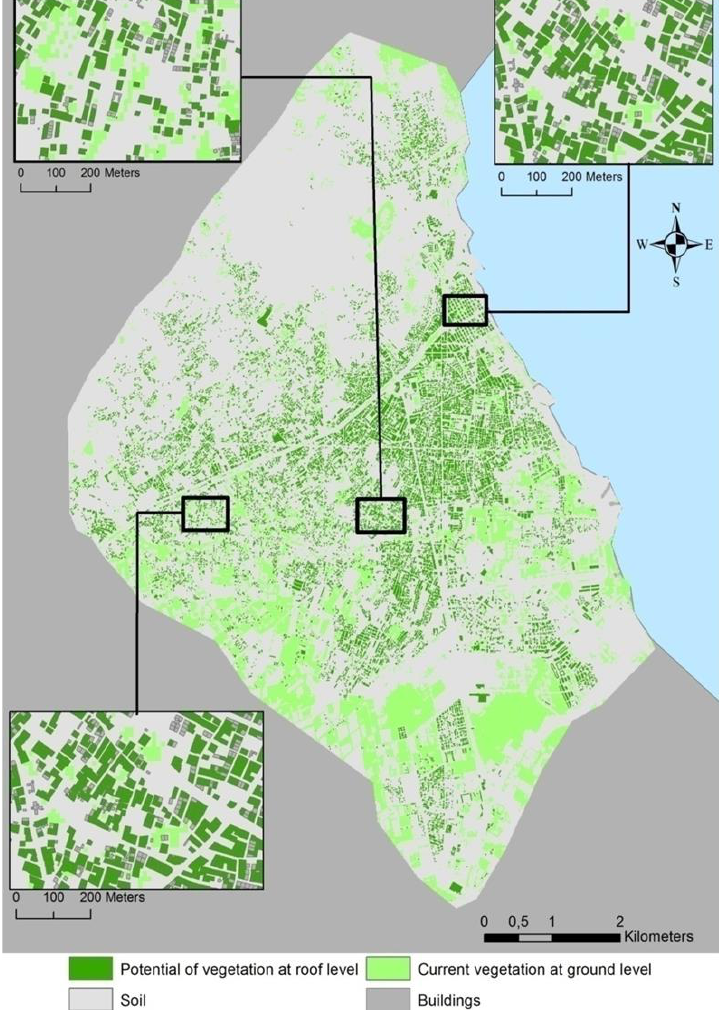
Figure 5. Current ground level vegetation cover and potential rooftop vegetation taking into account the flat roof and sloped roof scenario and the shaded to sunny